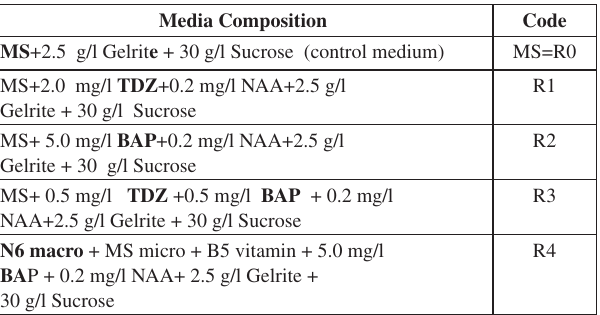
Table 1. Media used for regeneration of apple using leaf discs as explants Media